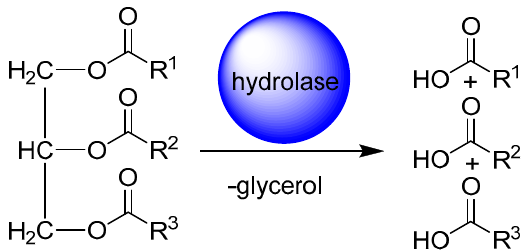
Figure 2. Enzymatic hydrolysis of oils, thus releasing fatty acids and glycerol.